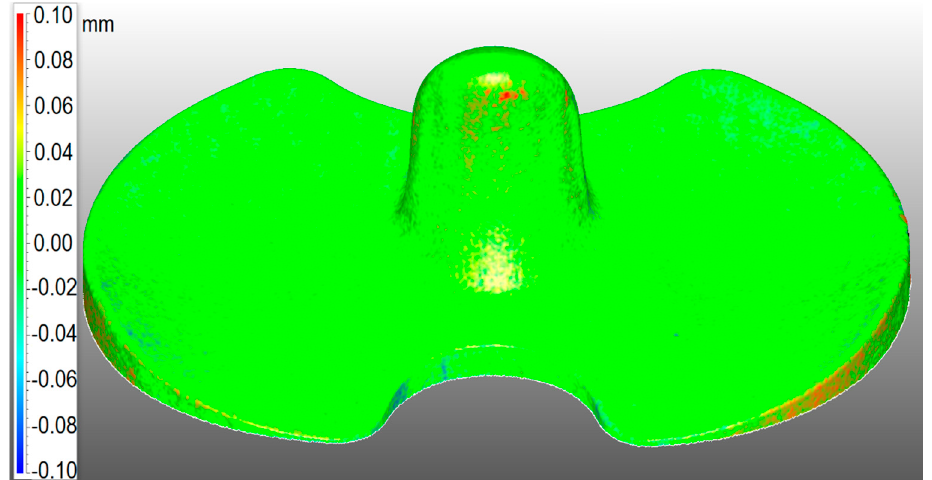
Figure 1. Comparison CAD-to-mesh on check A to control the uniformity of the coating.